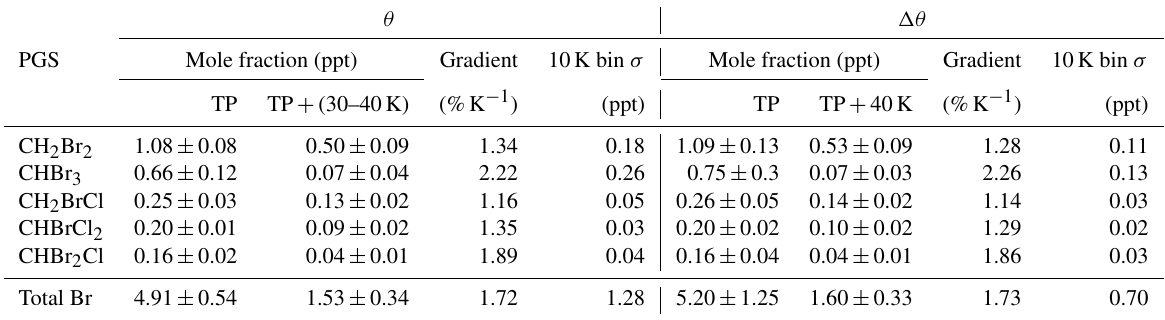
Table 4. Averaged mole fractions and vertical gradients of brominated VSLS during the PGS campaign. Data have been averaged using potential temperature, θ , and potential temperature difference to the tropopause, (cid:49)θ , as vertical profile coordinates. Tropopause (TP) mixing ratios are from the 10K bin below the dynamical tropopause (see text for details). The 10K bin standard deviations in the table represent the variability averaged over the four lowest stratospheric bins. The average potential temperature of the tropopause during the PGS campaign has been calculated from ECMWF data at the locations of our